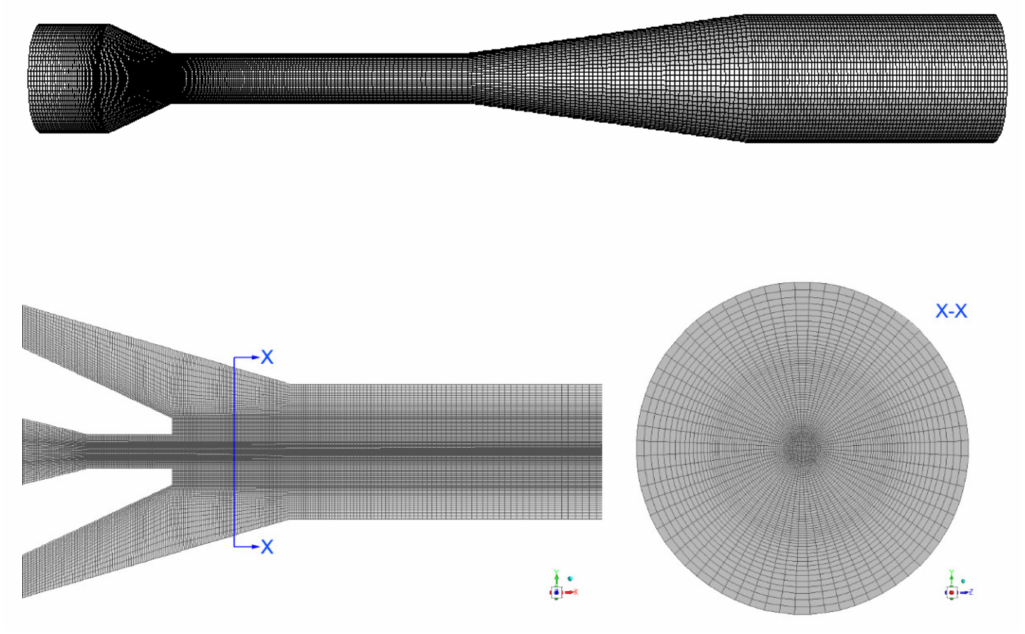
Figure 3. Grid of computational domain and cross-sections.